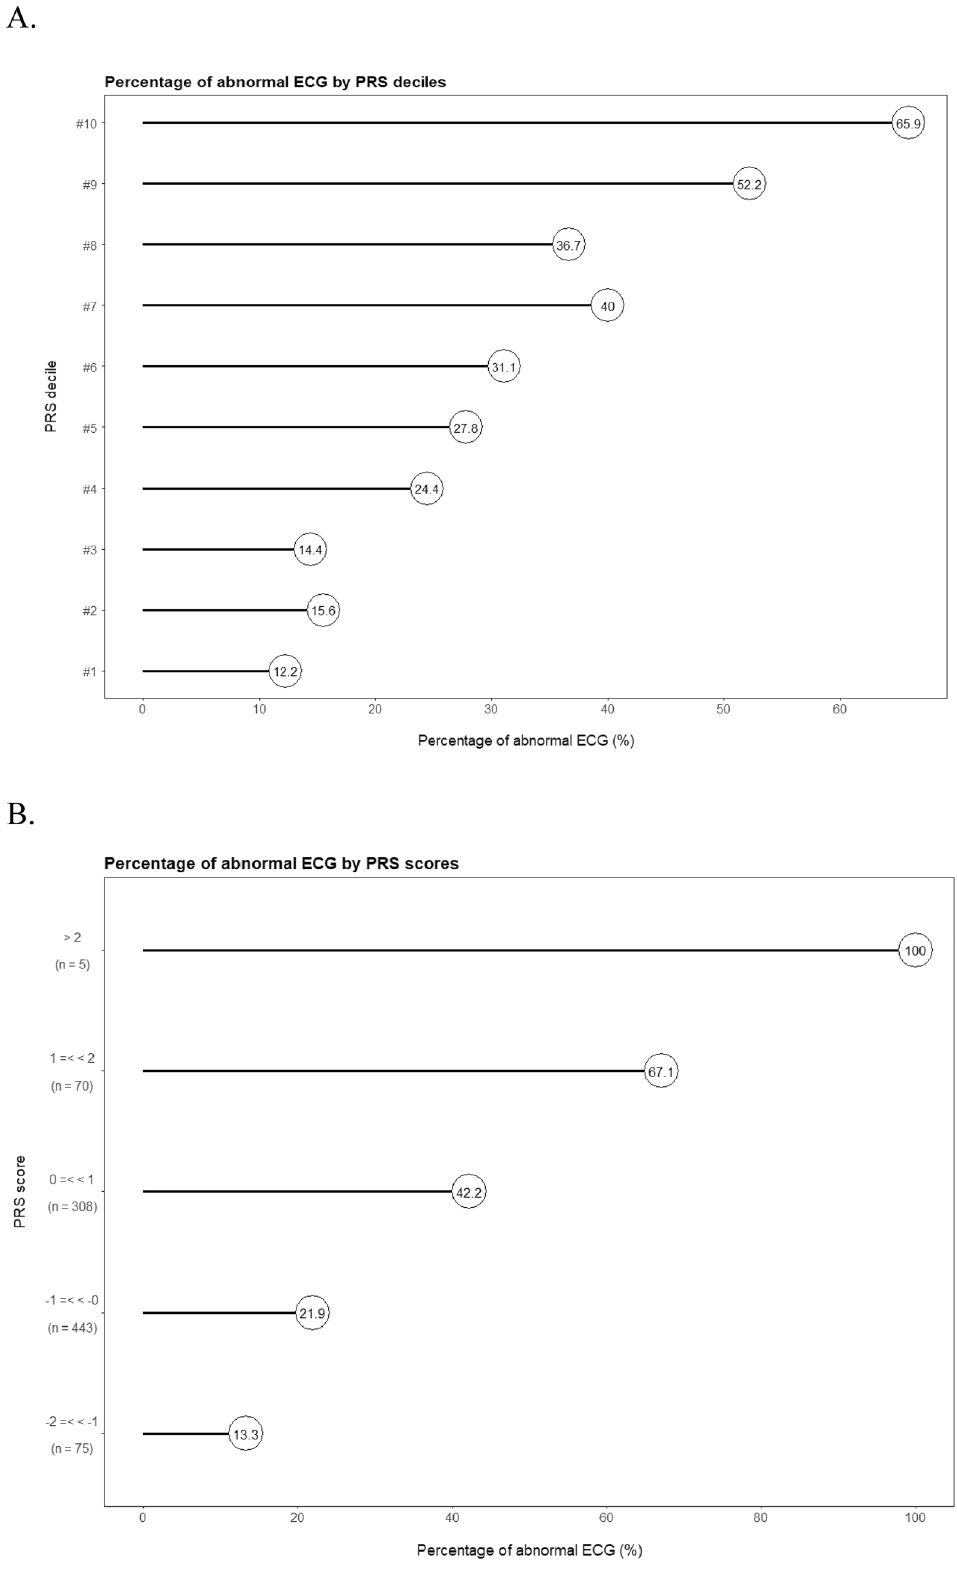
Figure 4. Percentage of abnormal ECG in subgroups of PRS deciles ( A ) and PRS scores ( B ). The ten deciles refer to the sequential 10% segments of the cohort ordered by the PRS values. For example, decile #1 annotates individuals with the lowest 10% PRS, and decile #10 annotates individuals with the highest 10%